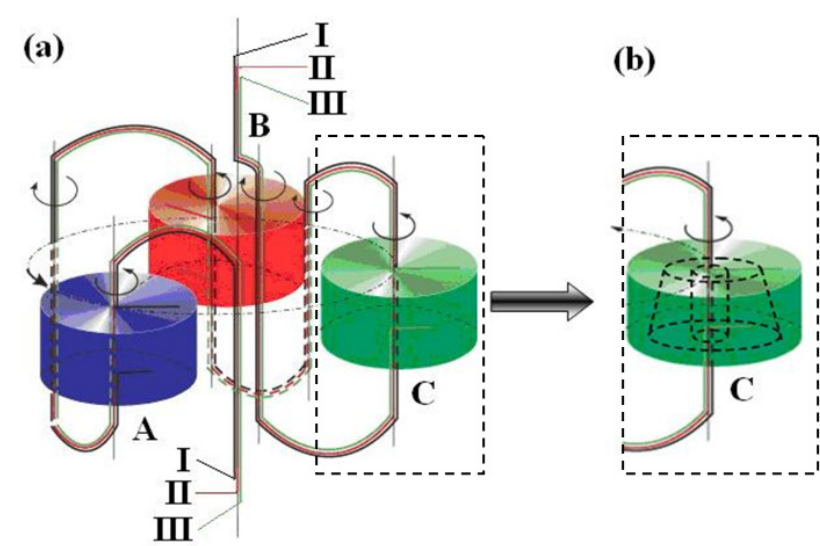
Figure 3. Three-channel CCC apparatus (a) and its modification